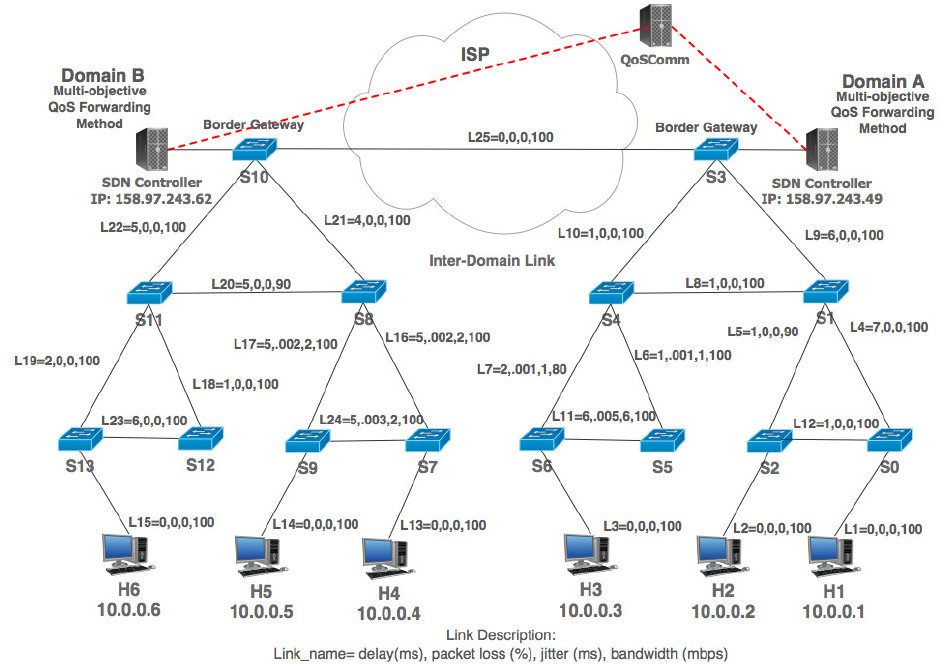
Figure 4. Network topology model for simulation. OpenFlow Switches (OFS): S0 to